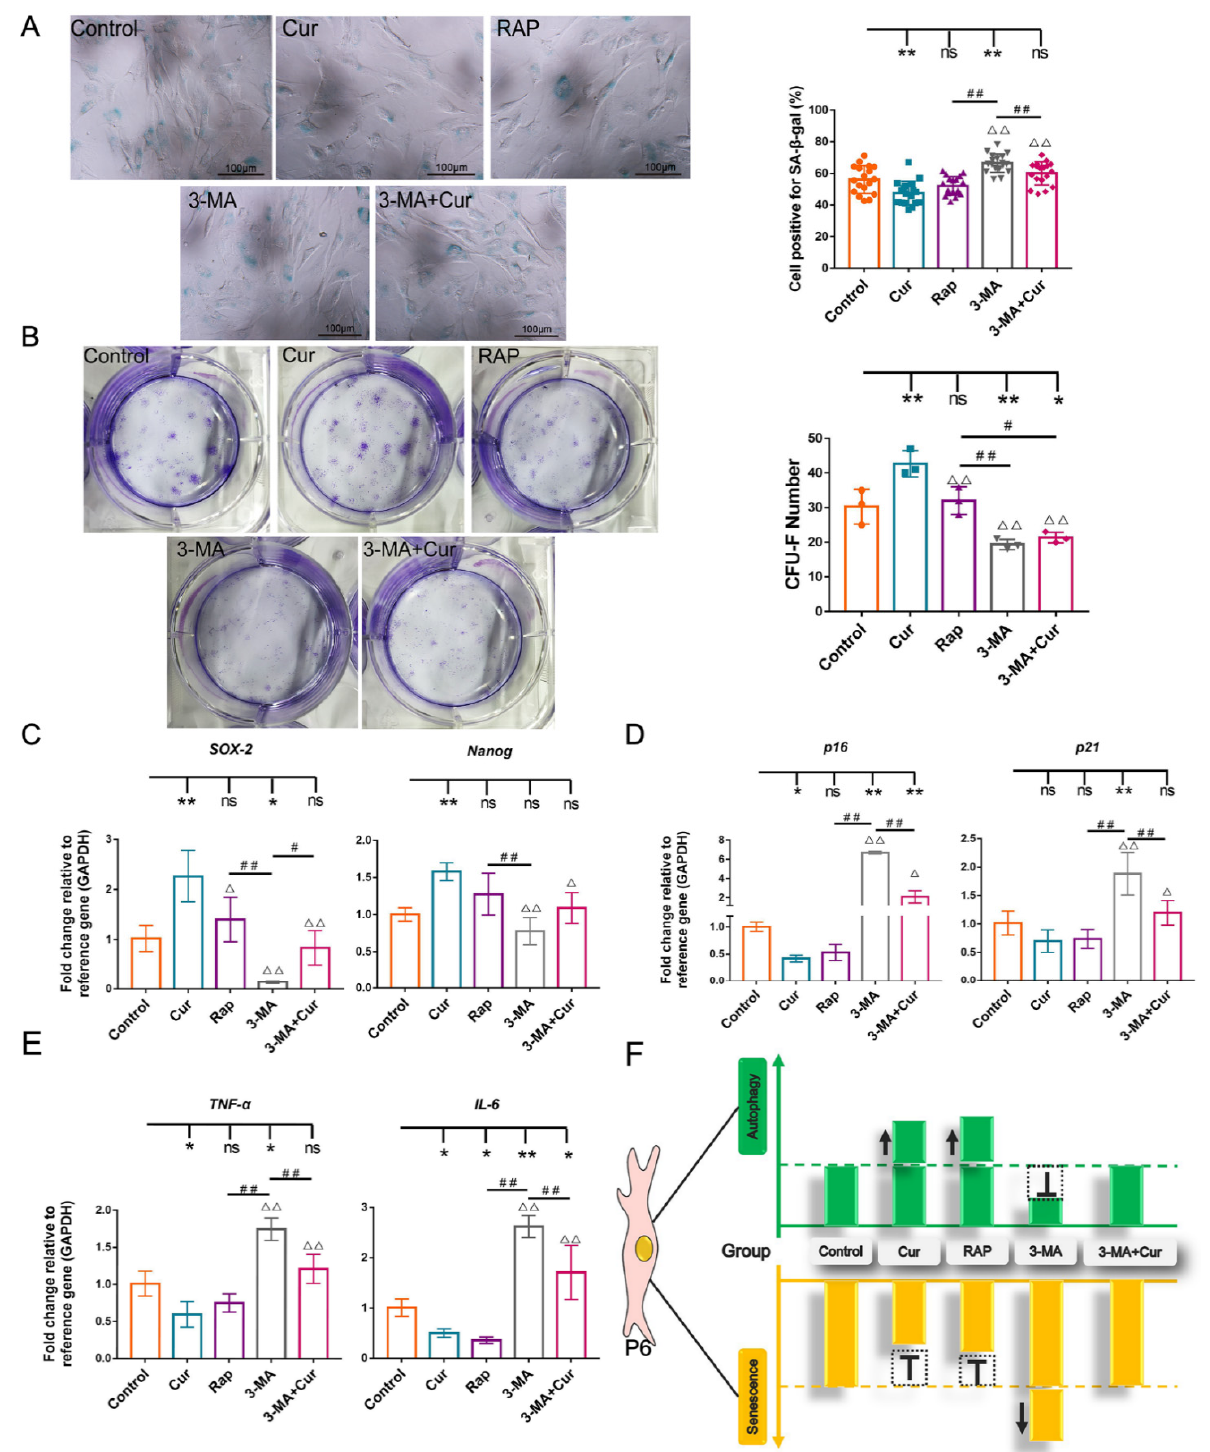
Figure 6. The effects of the modulation of autophagy through the employment of RAP (100 nM) and 3-MA (5 mM) on cBMSC (P6) senescence. ( A ) SA- β -gal expression levels in cBMSCs; scale bars = 100 μ m ( B ) The rate of colony formation in CFU-F. The expression of senescence-related genes p21 and p16 ( C ), pro-inflammatory cytokine genes TNF- α and IL-6 ( D ), and stemness markers Nanog and SOX-2 ( E ), as measured by RT-qPCR. ( F ) The potential relationship between Cur-induced autophagy and its effects on cBMSC senescence. The values are the means ± SDs of triplicate experiments; * p < 0.05, ** p < 0.01 compared with the control group; Δ p < 0.05, ΔΔ p < 0.01 compared with the Cur group; # p < 0.05, ## p < 0.01 for intragroup comparisons.